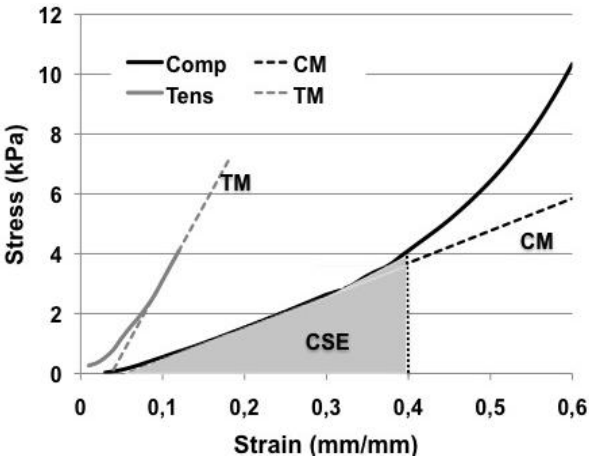
Figure 3. Mechanical behavior of collagen gels in terms of compression and tension with the slopes that were used to define the compressive modulus (CM) and tensile modulus (TM), respectively. The compressive strain energy (CSE) was defined as the integral between 0 and 40% of